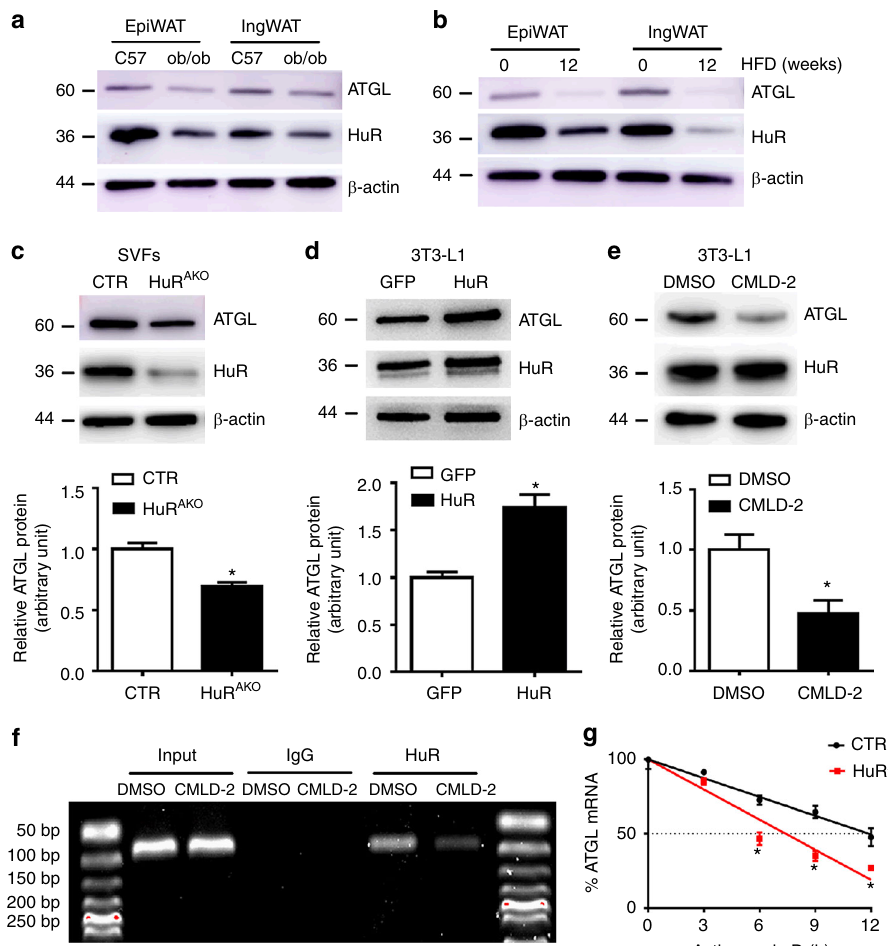
Fig. 5 HuR regulates ATGL mRNA stability. a Western blot analysis of HuR and ATGL expression in adipose tissue (epiWAT and ingWAT) of 20-week-old C57BL/6J and ob/ob mice and quanti fi cation ( n = 3), *comparison of ob/ob vs. C57. b Eight-week-old male C57BL/6J mice were fed with an HFD for an additional 12 weeks; western blot analysis of HuR and ATGL in adipose tissue and quanti fi cation ( n = 3), *comparison of HFD (12w) vs. HFD (0w). c SVFs were isolated from control and HuR AKO mice and differentiated to adipocytes. Western blot analysis of ATGL and quanti fi cation ( n = 3), *comparison of HuR AKO vs. control. d Differentiated 3T3-L1 adipocytes were infected with adenovirus expressing GFP or HuR for 48 h. Western blot analysis of ATGL protein level and quanti fi cation ( n = 3), *comparison of HuR vs. GFP. e 3T3-L1 adipocytes were stimulated with CMLD-2 (30 μ M) for 24 h. Western blot analysis of ATGL protein level and quanti fi cation ( n = 3), *comparison of CMLD-2 vs. DMSO. f Differentiated 3T3-L1 adipocytes were stimulated with CMLD-2 (30 μ M) or DMSO for 24 h. RNA immunoprecipitation with anti-HuR antibody or control IgG. g SVFs isolated from control and HuR AKO mice were differentiated to adipocytes and stimulated with 10 µ g mL − 1 actinomycin D. ATGL mRNA level was determined by qPCR ( n = 4), *comparison of HuR AKO vs. control. Data are represented as mean ± SEM. Signi fi cance was determined by Student ’ s t test analysis, * P < 0.05. Source data are provided